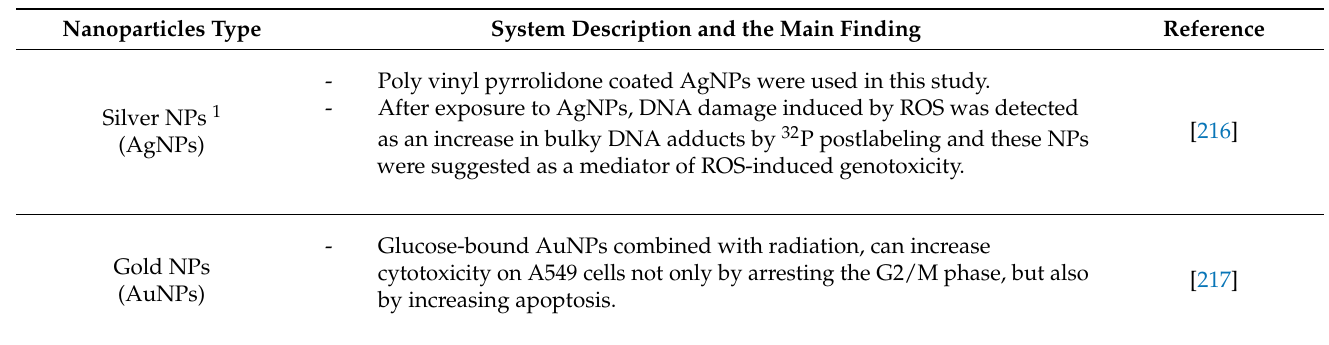
Table 3. Summary of some recent studies on design of nanoparticle-based delivery approaches for therapy against lung cancer. Nanoparticles